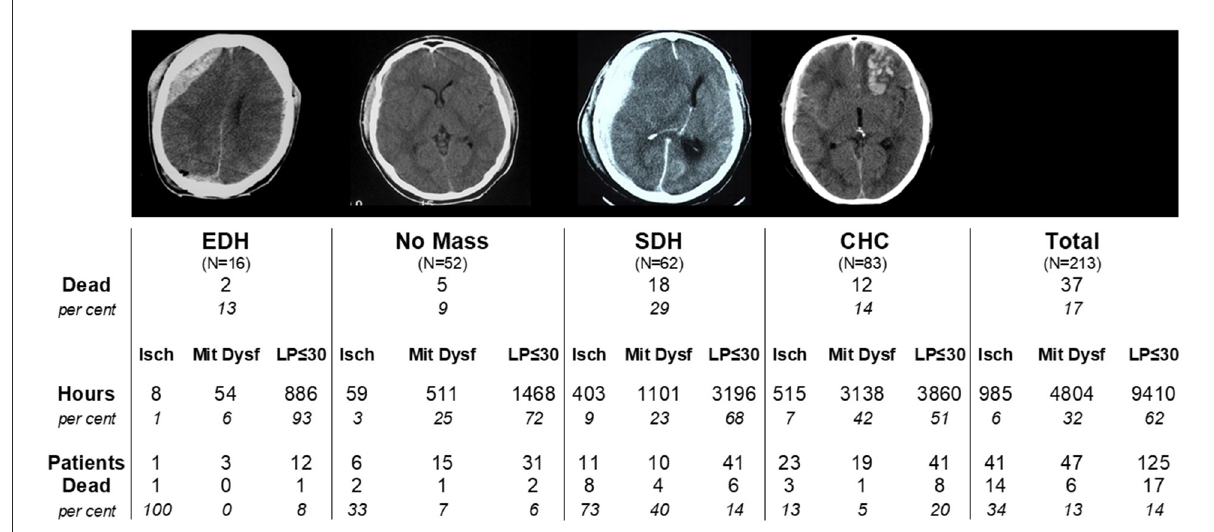
FIGURE8 Total mortality and mortality in four diagnostic groups of severe traumatic brain lesions in 213 patients: Extradural hematoma (EDH); Acute subdural hematoma (SDH); Focal cerebral hemorrhagic contusion (CHC); No Mass denotes patients not treated with surgical evacuation. Mortality is also shown separately for the biochemical subgroups defined as Ischemia (Isch), Mitochondrial Dysfunction (Mit Dysf) and normal aerobic metabolism (LP-ratio ≤ 30) within each diagnostic group. Data from (64).